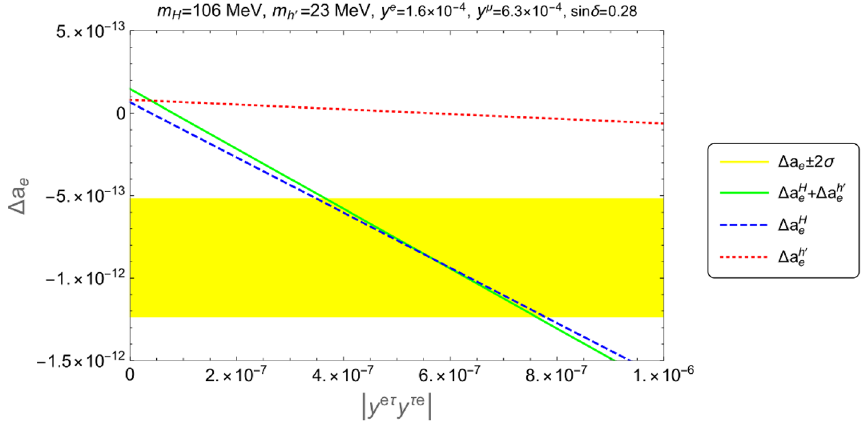
Figure 5 . Electron anomalous magnetic moment as a function of the absolute value of y eτ y τe . where r = m /m and y φ = y φ is the coupling strength of the scalar φ with the electron e X X ee e pair, as defined in eq. (3.24). To evade the BR( µ → eγ ) and BR( τ → µγ )